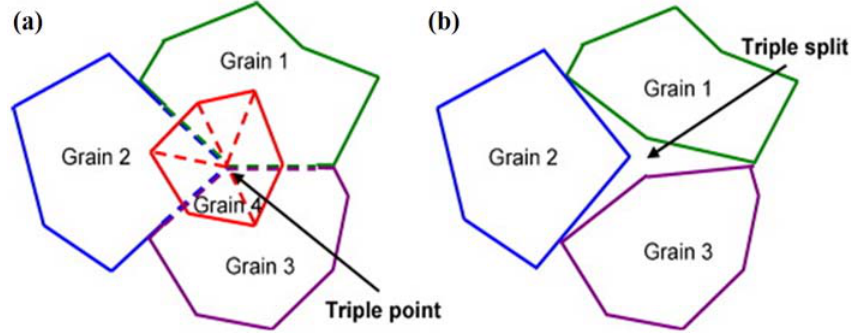
Figure 25. Illustration showing the triple damage failure ( a ) four grains structure; and ( b ) after losing grain No. 4 as a result of water hammer pressure [27].